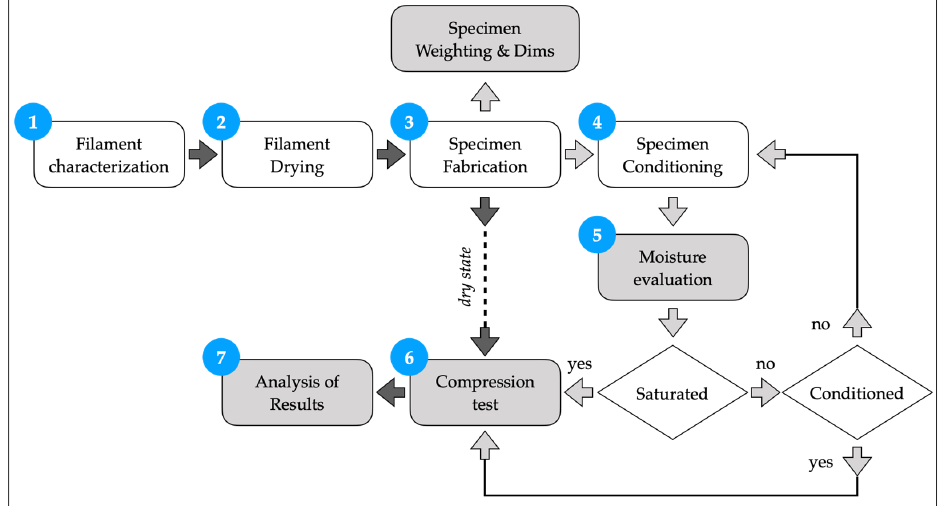
Figure 1. Flow diagram of the experimental activity.